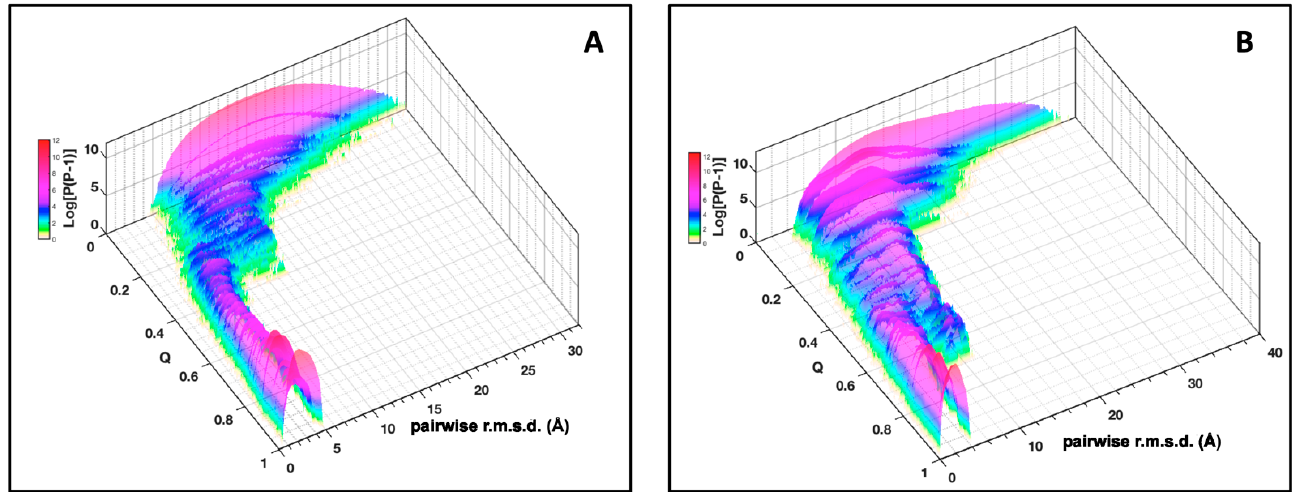
Figure 4. Distribution of pairwise r.m.s.d. for AVR-Pia ( A ) and AVR-Pib ( B ). The pairwise r.m.s.d. for a population of conformers (P) at each value of Q is given along the logarithmic vertical axis (Log[P(P - 1)]). These r.m.s.d. were binned at 0.125 Å.